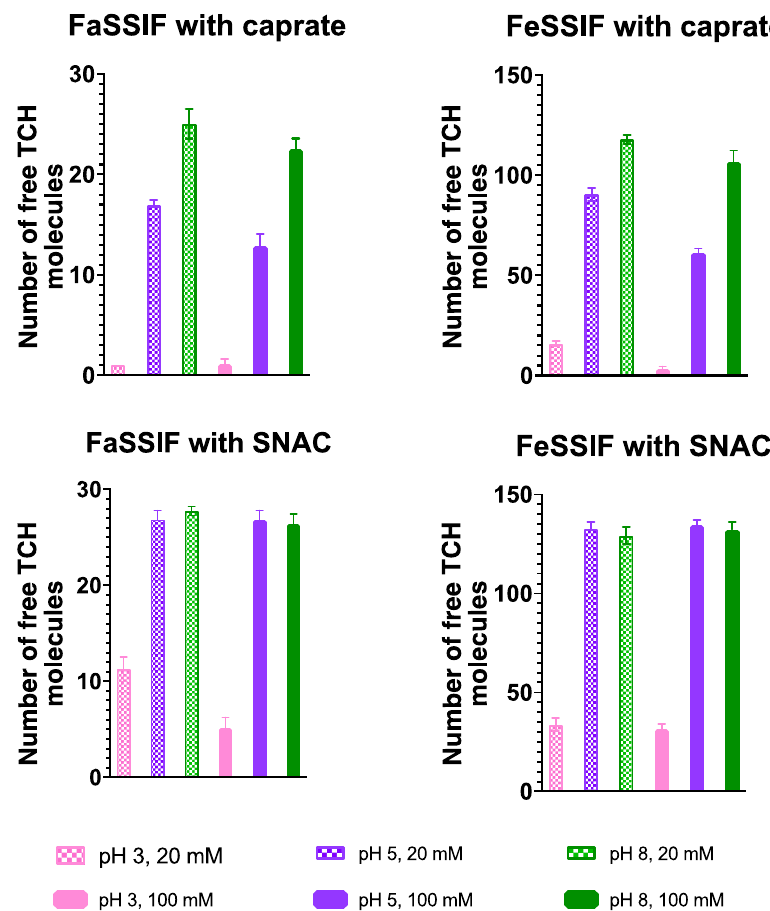
Figure 4. Number of free taurocholate (TCH) molecules for all studied systems, presented as an average value and standard deviation calculated using the last 200 ns of the simulation trajectory.